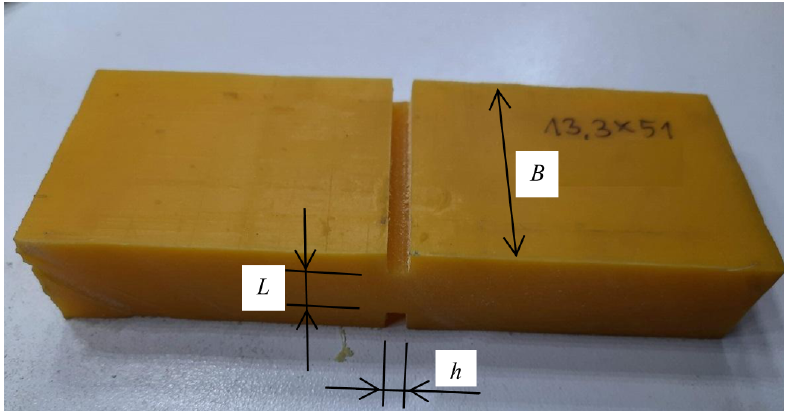
Figure 7. A sample of a viscoelastic material with a notch in the